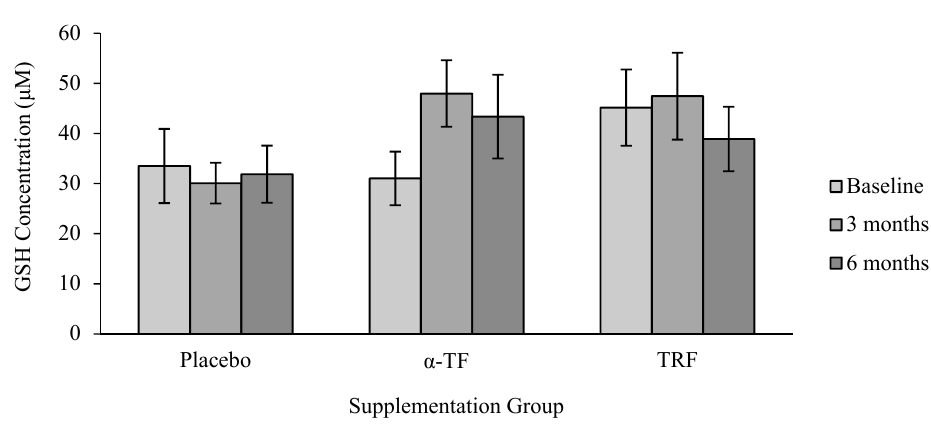
Figure 7. Effect of α -TF and TRF supplementation on glutathione (GSH) concentration for 6 months. The level of GSH remained unchanged throughout the supplementation period in both groups of vitamins.